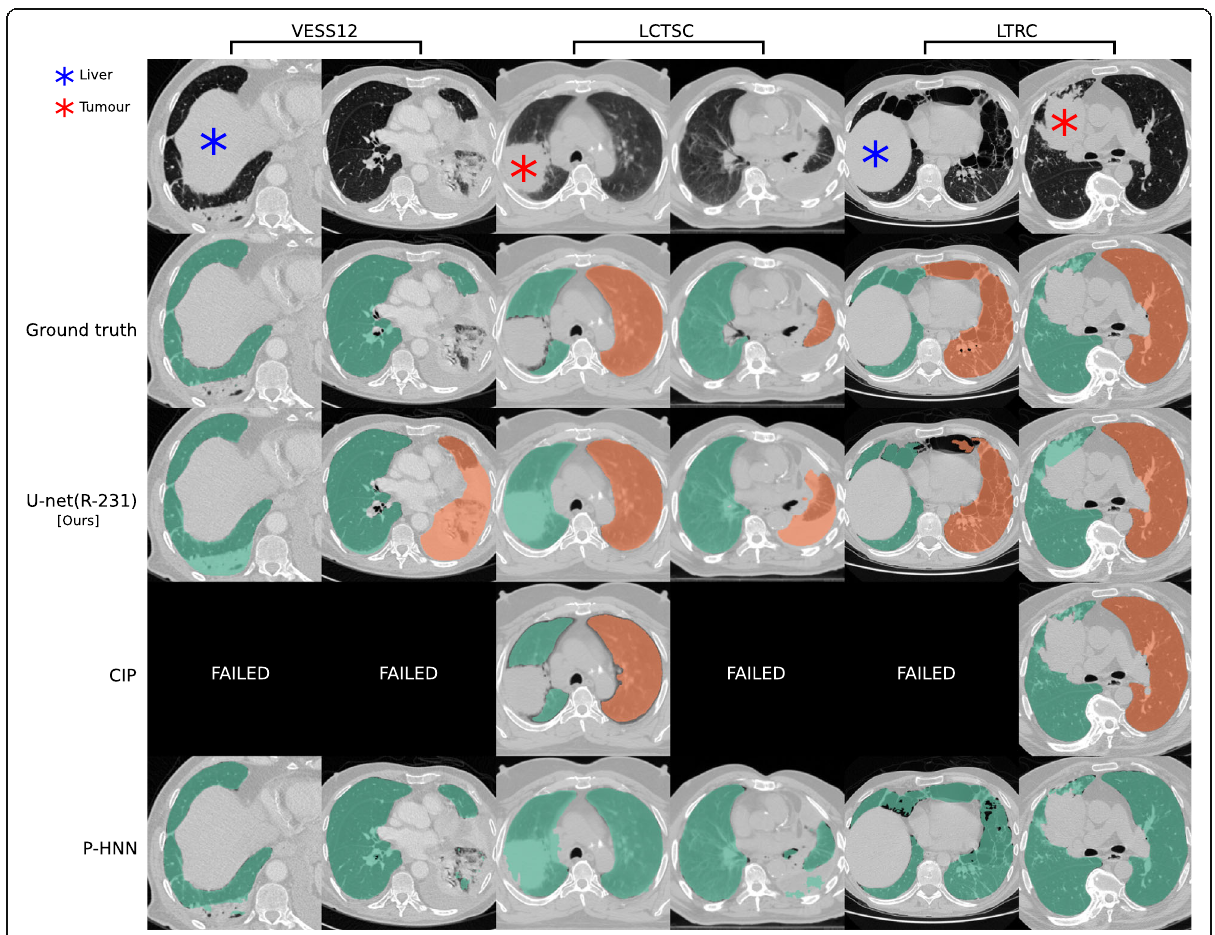
Fig. 3 Ground truth annotations in public datasets lack coverage of pathologic areas. Segmentation results for cases in public datasets where the masks generated by our U-net(R-231) yielded low Dice similarity coefficients when compared to the ground truth. Note that public datasets often do not include high-density areas in the segmentations. Tumours in the lung area should be included in the segmentation while the